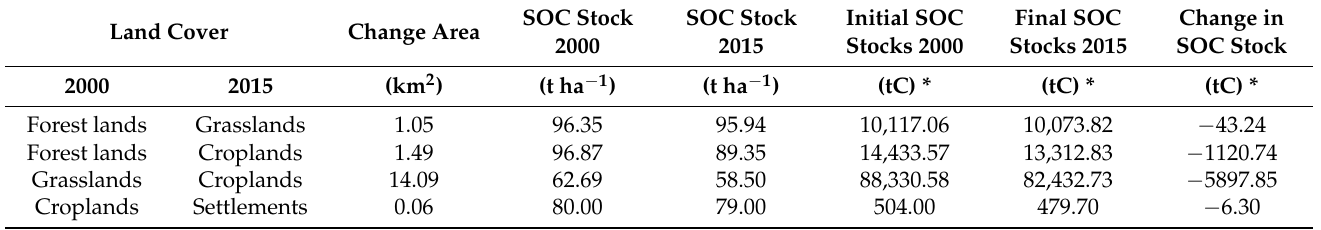
Table 5. SOC (Soil Organic Carbon) stock losses due to negative changes in LC in Ixtacamaxtitlan, 2000 – 2015.